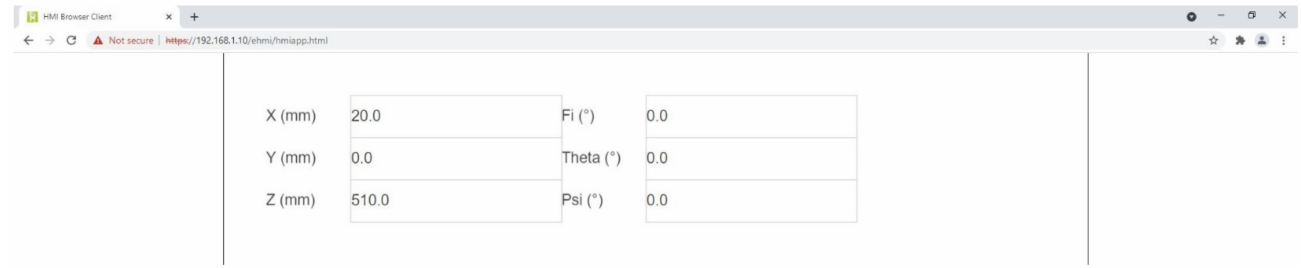
Figure 15. The HMI interface for the Stewart platform control.